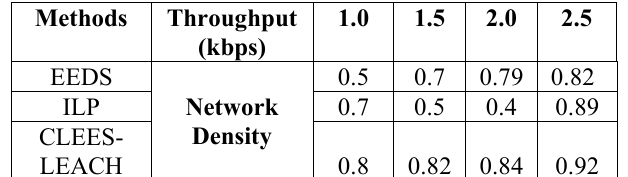
Table 6. Comparison Table for Throughput VS Network Density